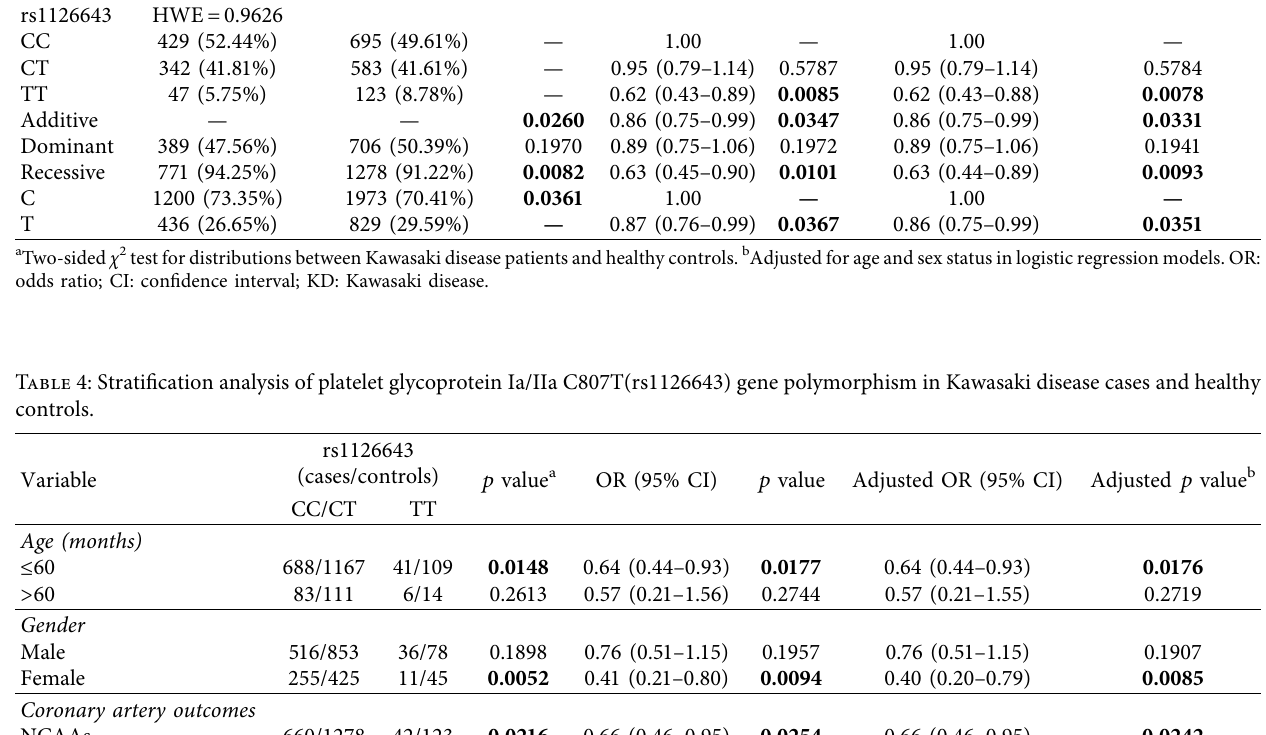
a Two-sided χ 2 test for distributions between Kawasaki disease patients and healthy controls. b Adjusted for age and sex status in logistic regression models. NCAAs: noncoronary artery aneurysms; CAAs: coronary artery aneurysms; OR: odds ratio; CI: confidence interval; KD: Kawasaki disease.